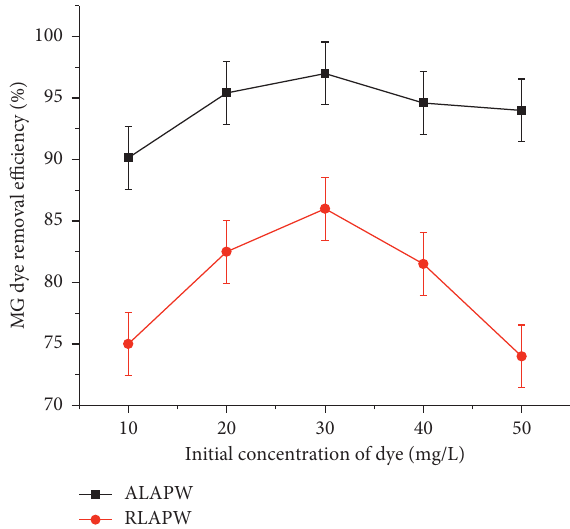
Figure 8: Temperature effect on MG dye removal by ALAPW and RLAPW at adsorbent dose 0.2 g, pH 4 (ALAPW) and pH 6 (RLAPW), initial MG dye concentration 30mg/L, and contact time 60min with agitation speed